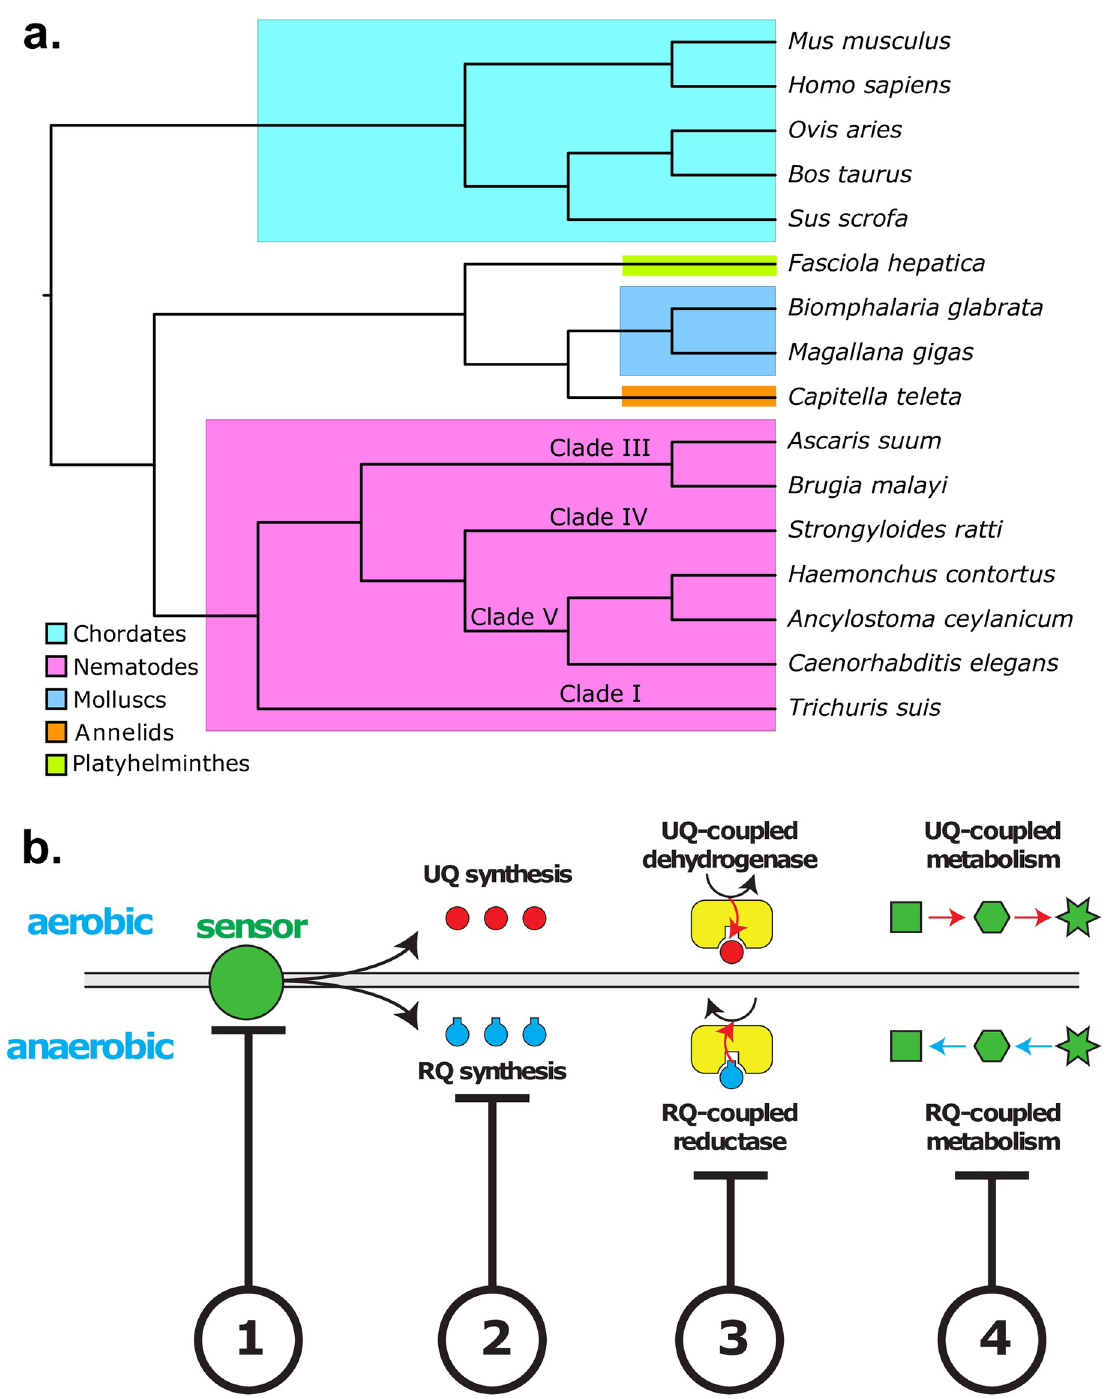
Fig 1. Identification of potential anthelmintic targets that act in various aspects of RQ-dependent metabolism. a) Evolutionary tree of the species whose sequences are used in this paper. Species are grouped according to the phylum: chordates (the mammalian hosts, cyan), platyhelminthes (chartreuse), molluscs (blue), annelids (orange) and nematodes (magenta). Helminths are further identified by their clade. The tree was generated with {rotl} [36]. b) Genes involved in regulating four main areas of RQ-dependent metabolism are candidate genes for helminth-specific inhibitors. (1) Genes that act to sense and regulate the switch from UQ to RQ-dependent metabolism as STHs migrate to anaerobic environments in the hosts are potential anthelmintic targets (‘sensors’) (2) Genes involved in RQ synthesis (3) The Quinone-dependent Dehydrogenases (QDHs) that interact with RQ (4) Other metabolic enzymes downstream of QDHs that are important for the rewiring of metabolic pathways in anerobic environments are also potential targets.